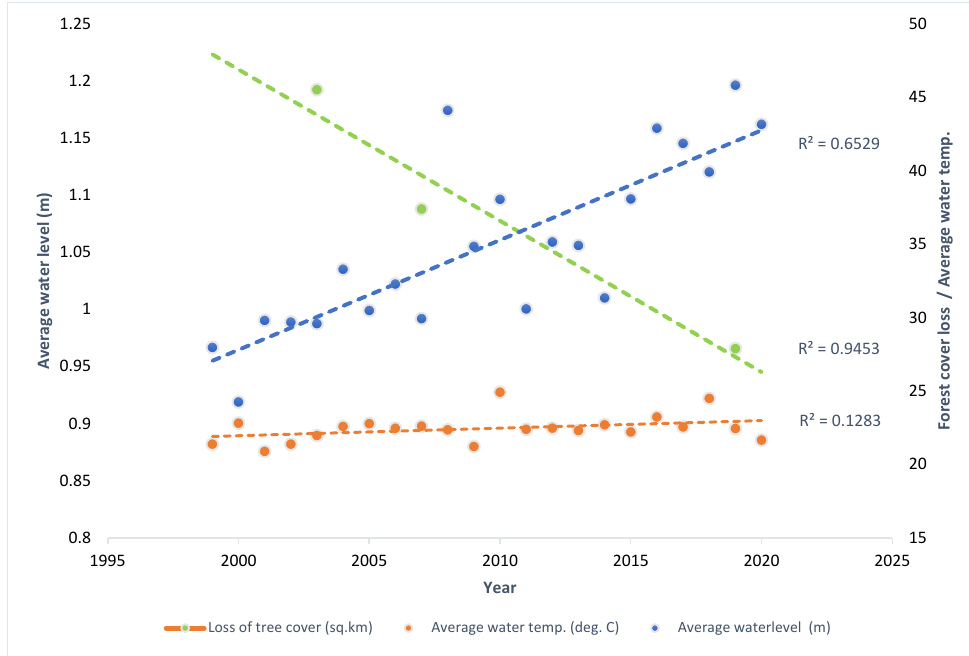
the study period. Time proved to be a good indicator for increase in water level and for uses 2007 NAIP imagery. Black shaded areas indicate current year forest extent, and the red hashed decrease in forest cover (Figure 6). The lack of tree ‐ cover samples prohibited many statis ‐ areas indicate loss. tical comparisons, but visually the correspondence seems evident.